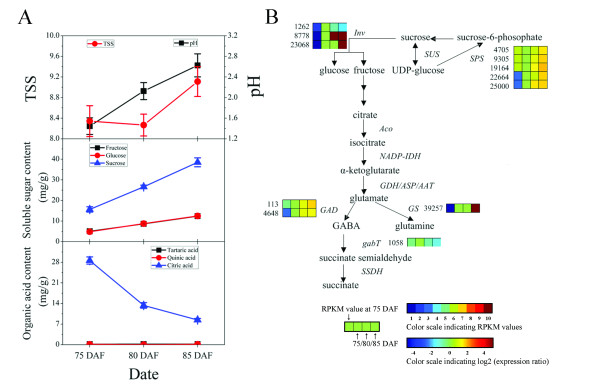
Schematic of physiological and metabolic data related to bayberry fruit taste during ripening. (A) Changes in TSS, pH, content of soluble sugars, and content of organic acids, (B) Sucrose metabolism and organic acid degradation through the GABA shunt. Enzyme names, UniGene ids and expression patterns are indicated at the side of each step. The expression patterns of each UniGene are shown by 4 grids, with the left one representing the RPKM value at 75 DAF, and the second to fourth ones from the left to the right representing the relative log2 (expression ratio) at 75, 80, 85 DAF, respectively. The grids with 10 different colors from blue to red show the absolute expression magnitude at 75 DAF, with the RPKM values 0-10, 10-20, 20-40, 40-80, 80-160, 160-320, 320-640, 640-1280, 1280-2560, and over 2560 represented by color 1 to 10, respectively.